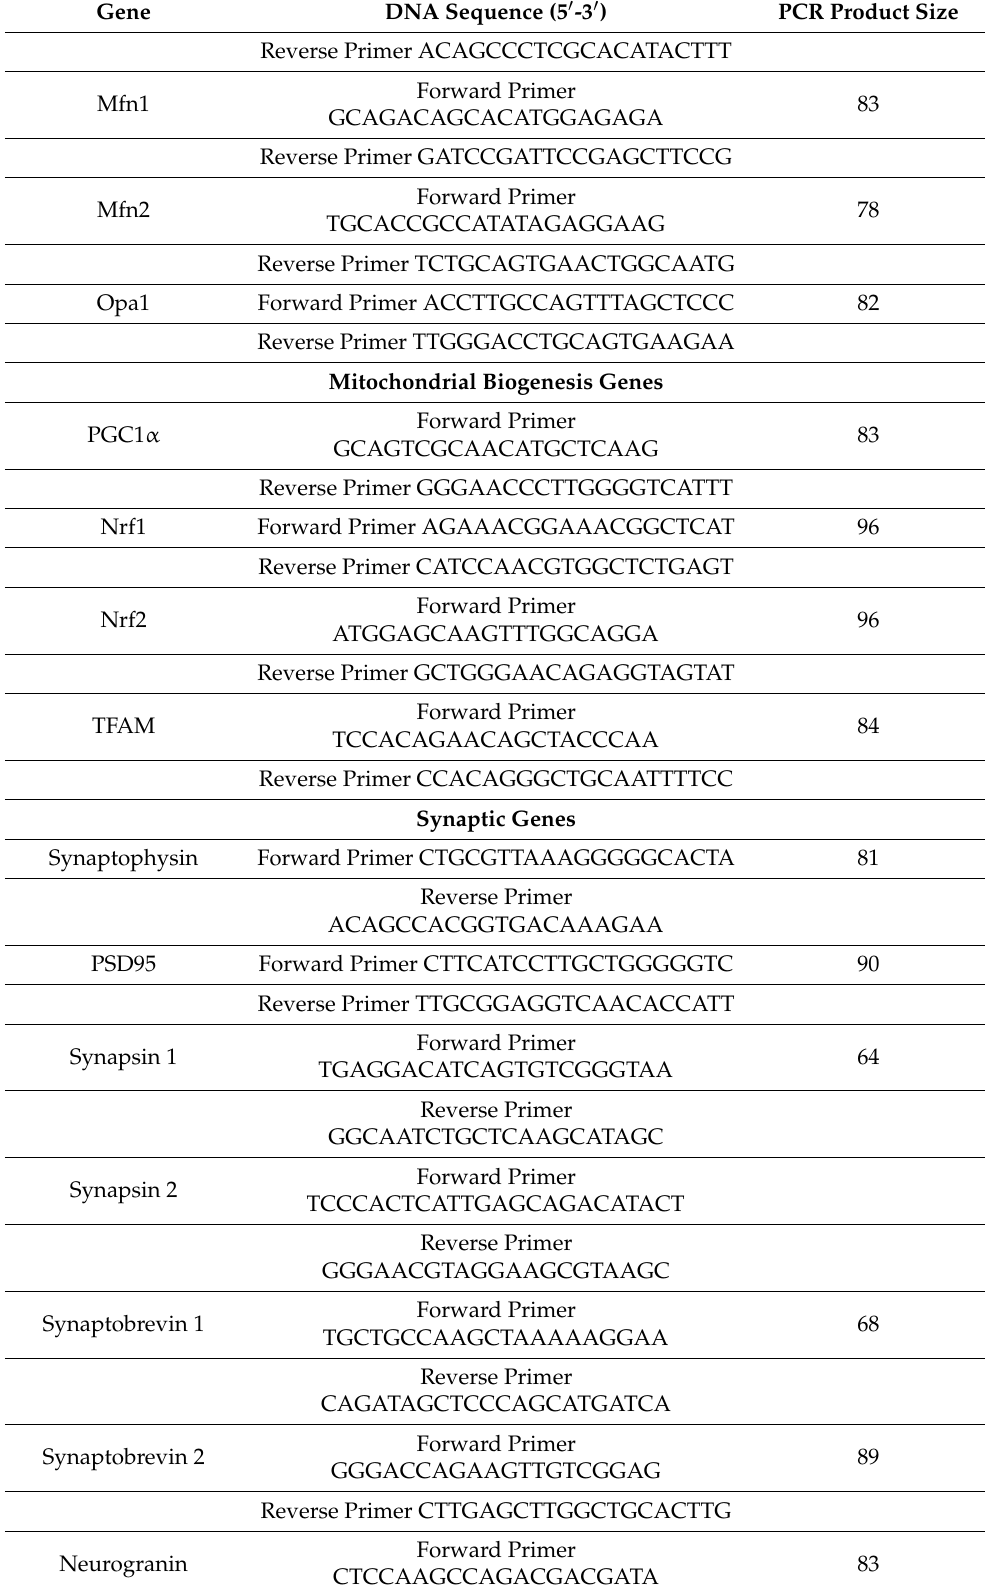
Table 1. Cont. Gene DNA Sequence (5 (cid:48) -3 (cid:48)